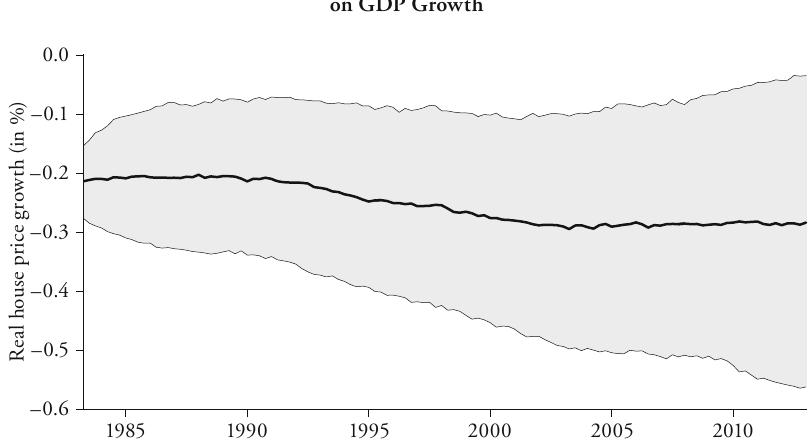
Figure 11: Effect (after 8 Quarters) of House Price Responses to a Shock on GDP